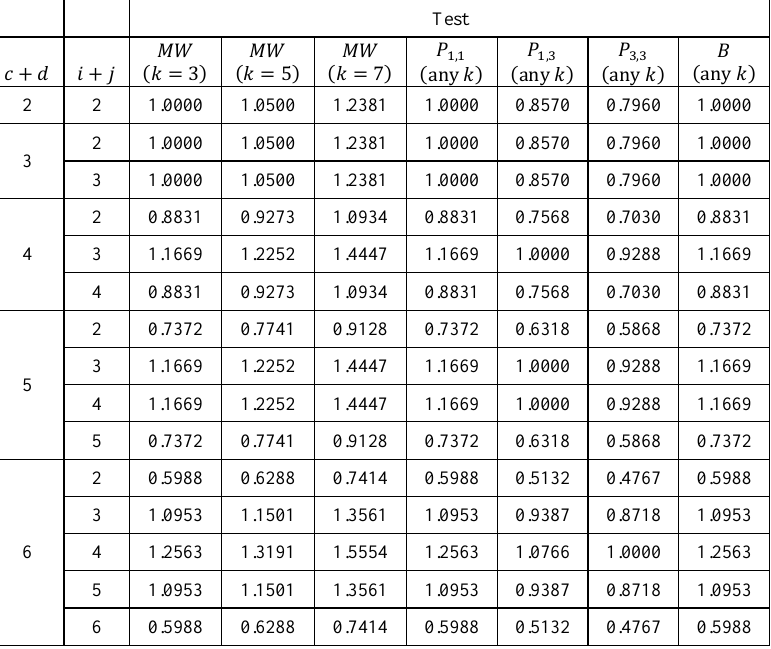
Table 6. AREs of 𝑇 for Cauchy distribution w.r.t. different tests 𝑐,𝑑;𝑖,𝑗